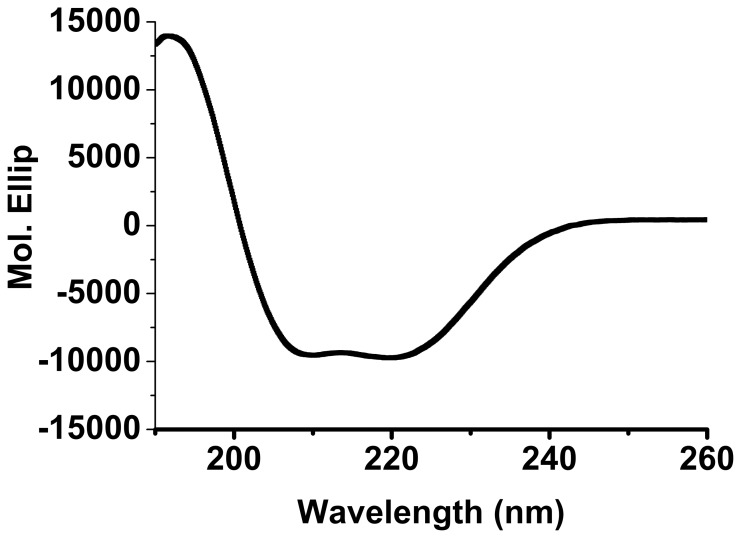
Circular Dichroism (CD) spectrum of RPMi.